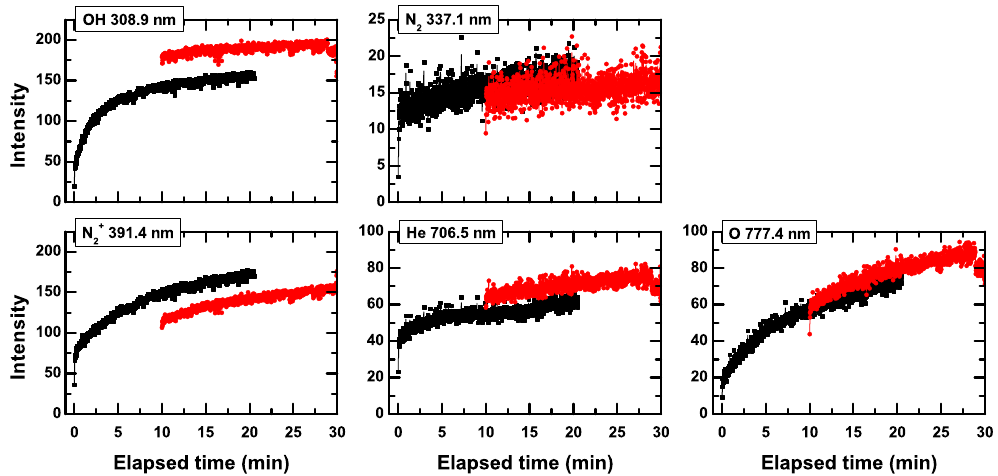
Figure 5. Influence of elapsed time on selected bands and lines integral intensity (HV pulse parameters: 8 kV, 2 kHz, 50 µ s, positive polarity). Black dots: gas flow and HV pulses turned on simultaneously; Red dots: gas flow turned on for 10 min prior the HV